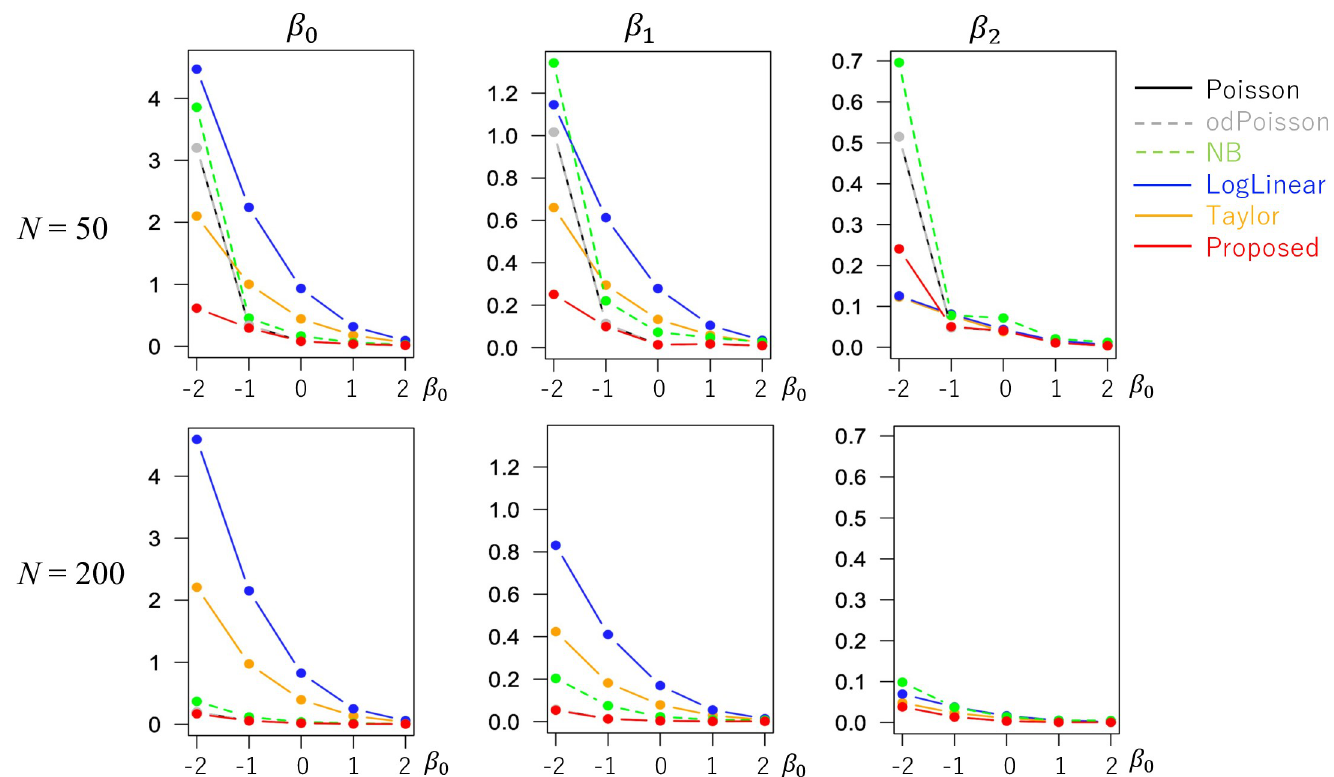
Fig 3. RMSE of the regression coefficients in cases with overdispersion ( σ 2 = 5.0) (x − axis: β 0 , y-axis: RMSE).